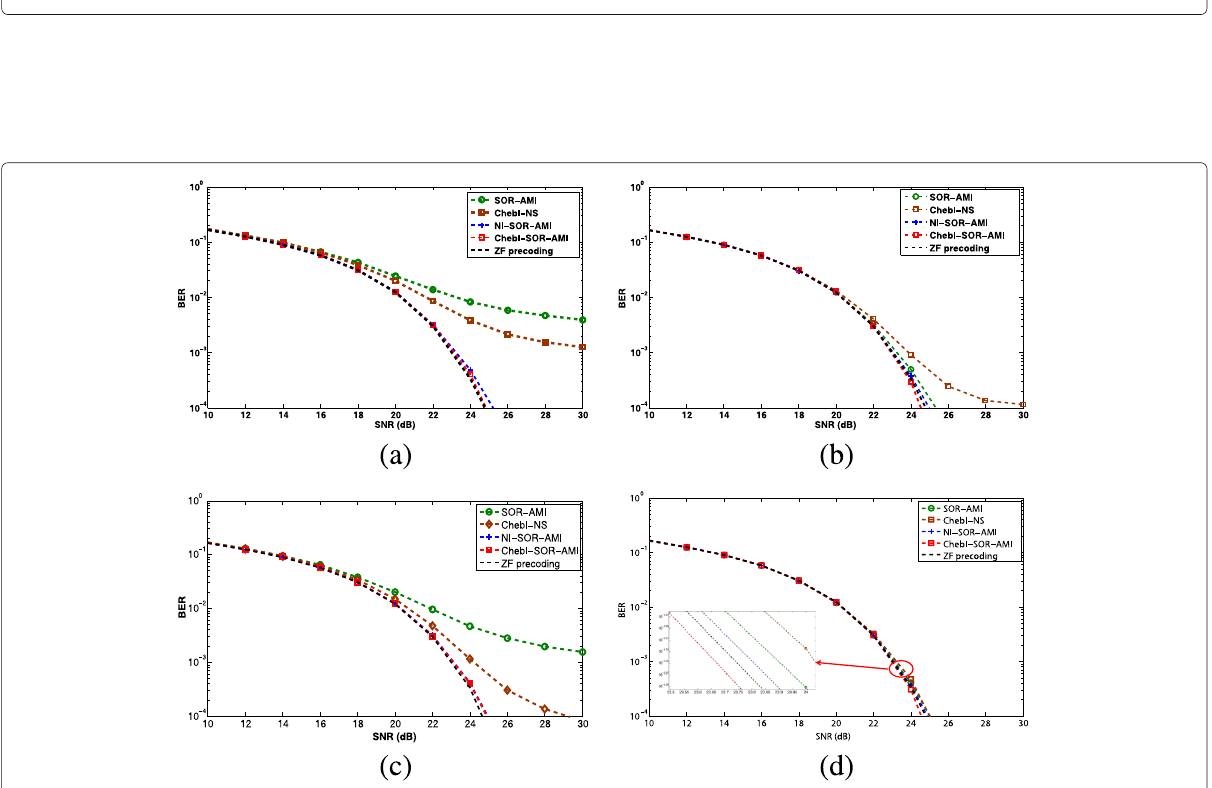
Fig. 5 BER performance comparison between the new proposed methods with N × K = 128 × 16 mMIMO system for uncorrelated and correlated channel conditions. This figure compares between the proposed methods in this paper under correlated and uncorrelated channel conditions for the second and fourth iterations respectively. a Uncorrelated channel, i = 2. b Uncorrelated channel, i = 4. c Correlated channel, i = 2. d Correlated channel, i =